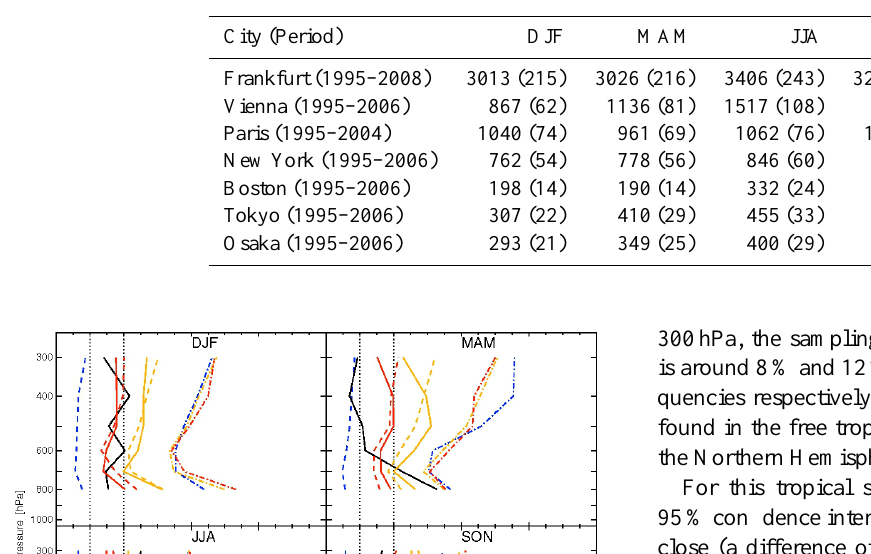
Table 4. Number of profiles collected per season over the 14 yr period 1995–2008 by the MOZAIC aircraft over Frankfurt, Vienna, Paris, New York, Boston, Tokyo and Osaka. Numbers in parenthesis are the average numbers of profiles collected per season per year.